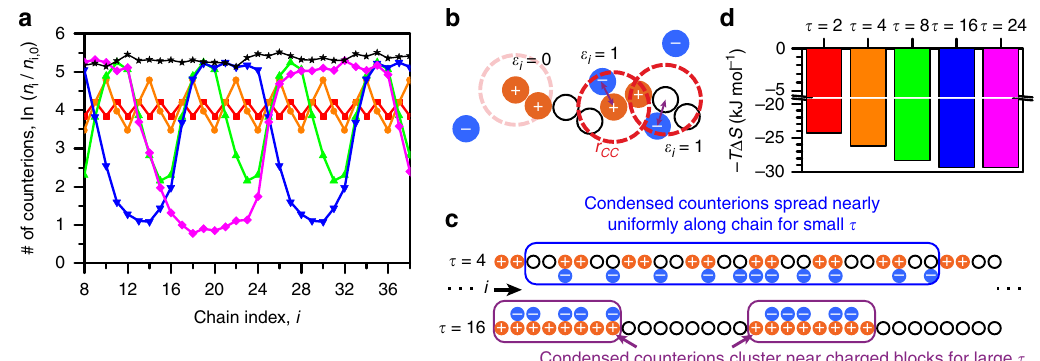
Fig. 6 Charge sequence effects in coacervation can be explained by 1D counterion con fi nement entropy. a The number of counterions n i condensed as a function of chain index i , relative to the counterions present near an uncharged chain, n i ,0 . Salt concentration is 25 mM, at boxed supernatant points in Fig. 2a. The value ln( n i / n i ,0 ) is related to an effective binding energy used in a 1D adsorption model. Colors same as Fig. 2a and d , black curve for homopolyanion. b The criterion for a condensed counterion is one that is within r CC of a polyelectrolyte charge; it is ‘ condensed ’ along the nearest polymer bead of index i . c Conceptual schematic demonstrating the origin of the charge sequence effect on coacervation. Condensed counterions are uniformly distributed along polyelectrolyte chains with low τ , however at high τ these condensed counterions are con fi ned along-the-chain contour near the charged blocks. This additional con fi nement increases the entropic driving force for counterion release. d This 1D con fi nement is re fl ected in the entropic contribution to the free energy, − T Δ S , as calculated from the 1D adsorption model and in near-quantitative matching with ITC data (Fig.